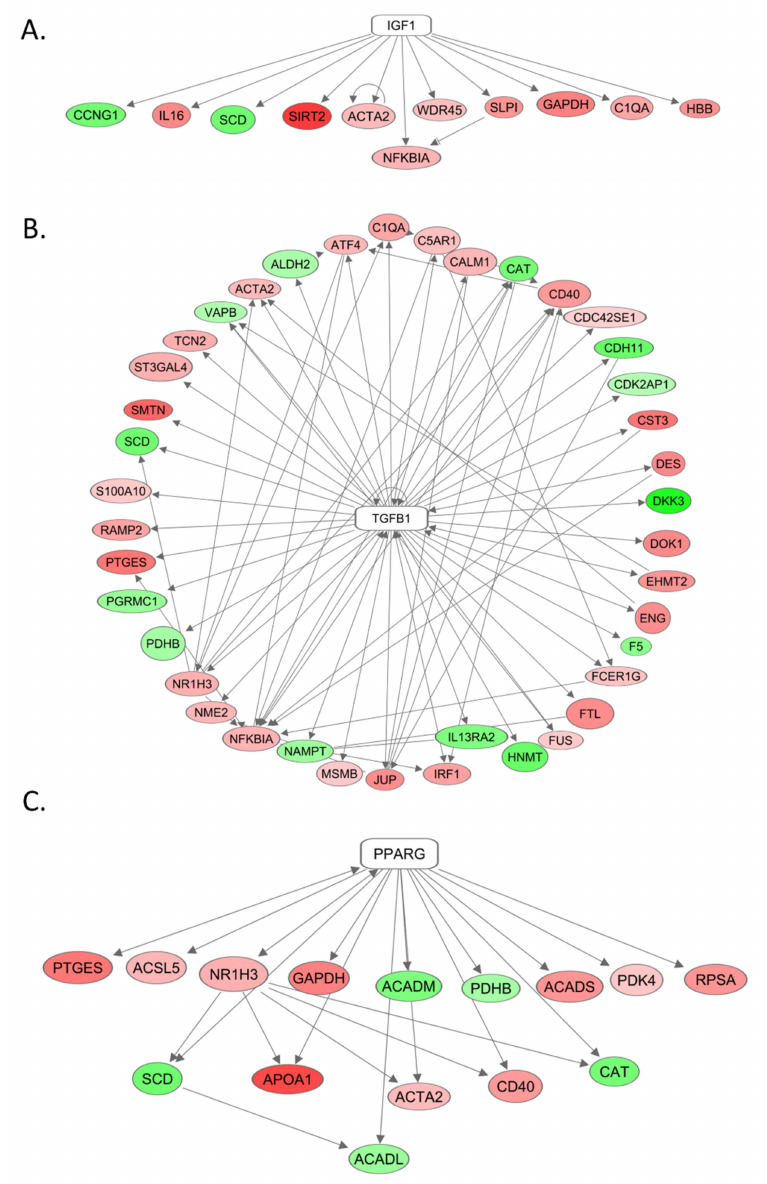
Figure 8. Schematic depiction of RNAseq analysis showing the key signaling nodes affected by irradiation in the hearts of minipigs. By mRNA sequencing and analysis, IGF-1 ( A ), TGF-beta ( B ), and PPAR-gamma ( C ) were identified as predicted upstream regulators in the heart of irradiated minipigs per z-score calculation. The oval and rectangular nodes represent candidate genes and corresponding regulators, respectively. The arrow-headed edges represent the relationships between the two nodes, and the red and green colors denote up- and down-regulated nodes,